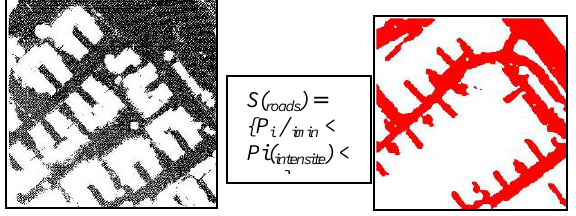
Figure 5: Extraction of Road class from “ground & road”.